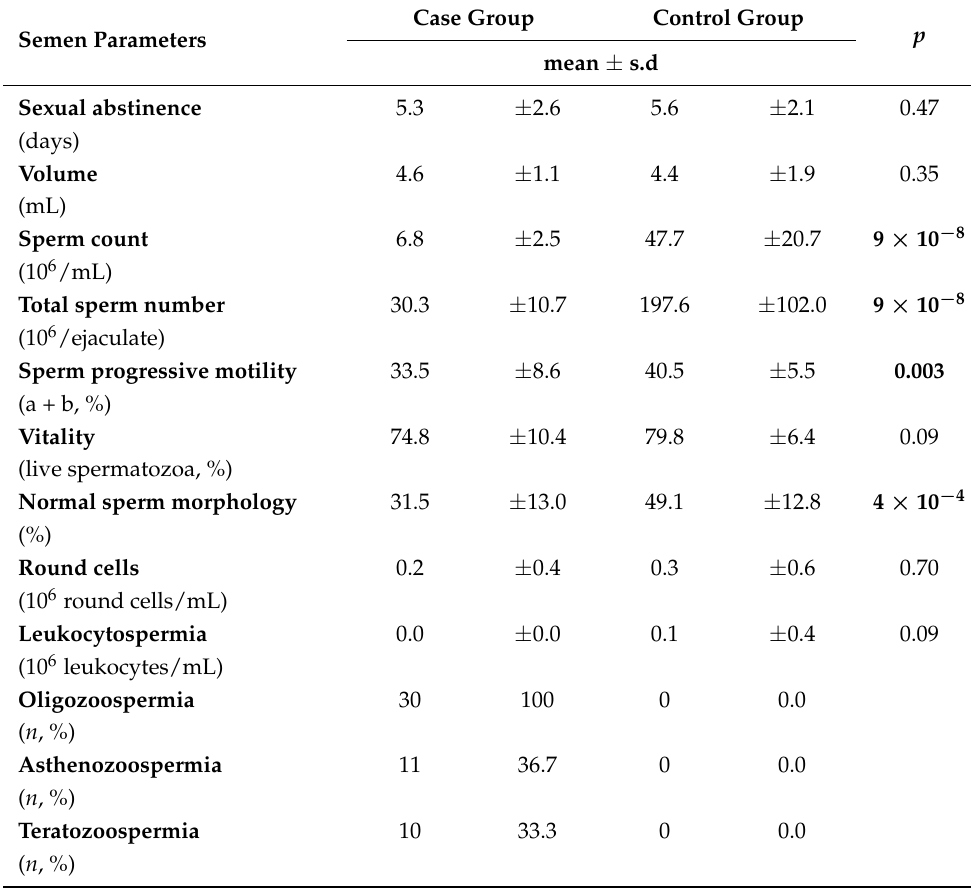
Table 2. Conventional semen parameters in case and control